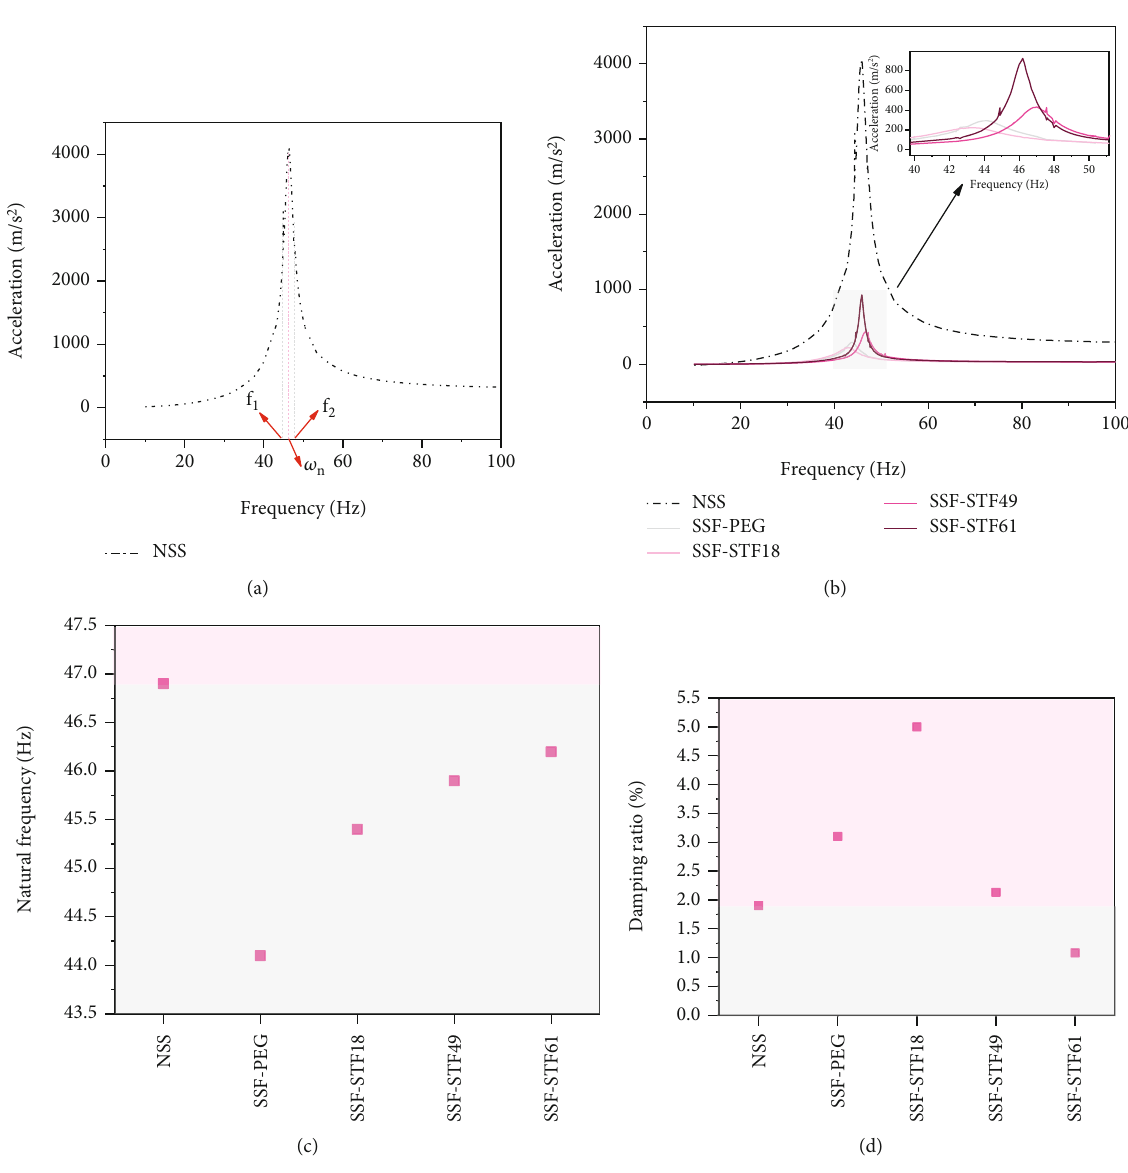
Figure 7: The frequency response curve of (a) NSS and (b) NSS, SSF-PEG, SSF-STF18, SSF-STF49, and SSF-STF61. (c) The natural frequency and (d) damping ratio of each